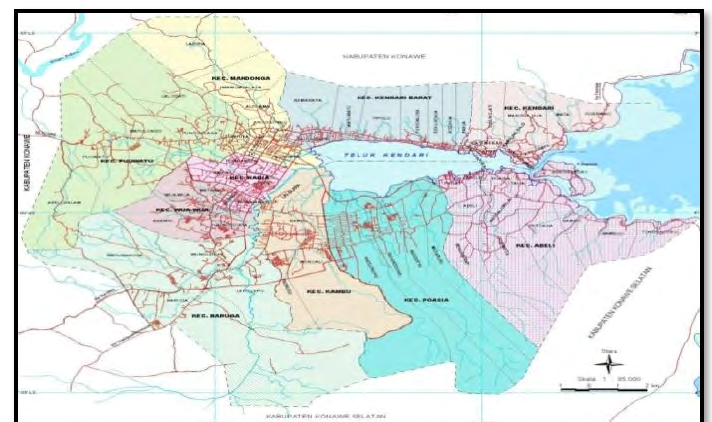
Figure 1. Map of Adiministration of Kendari City